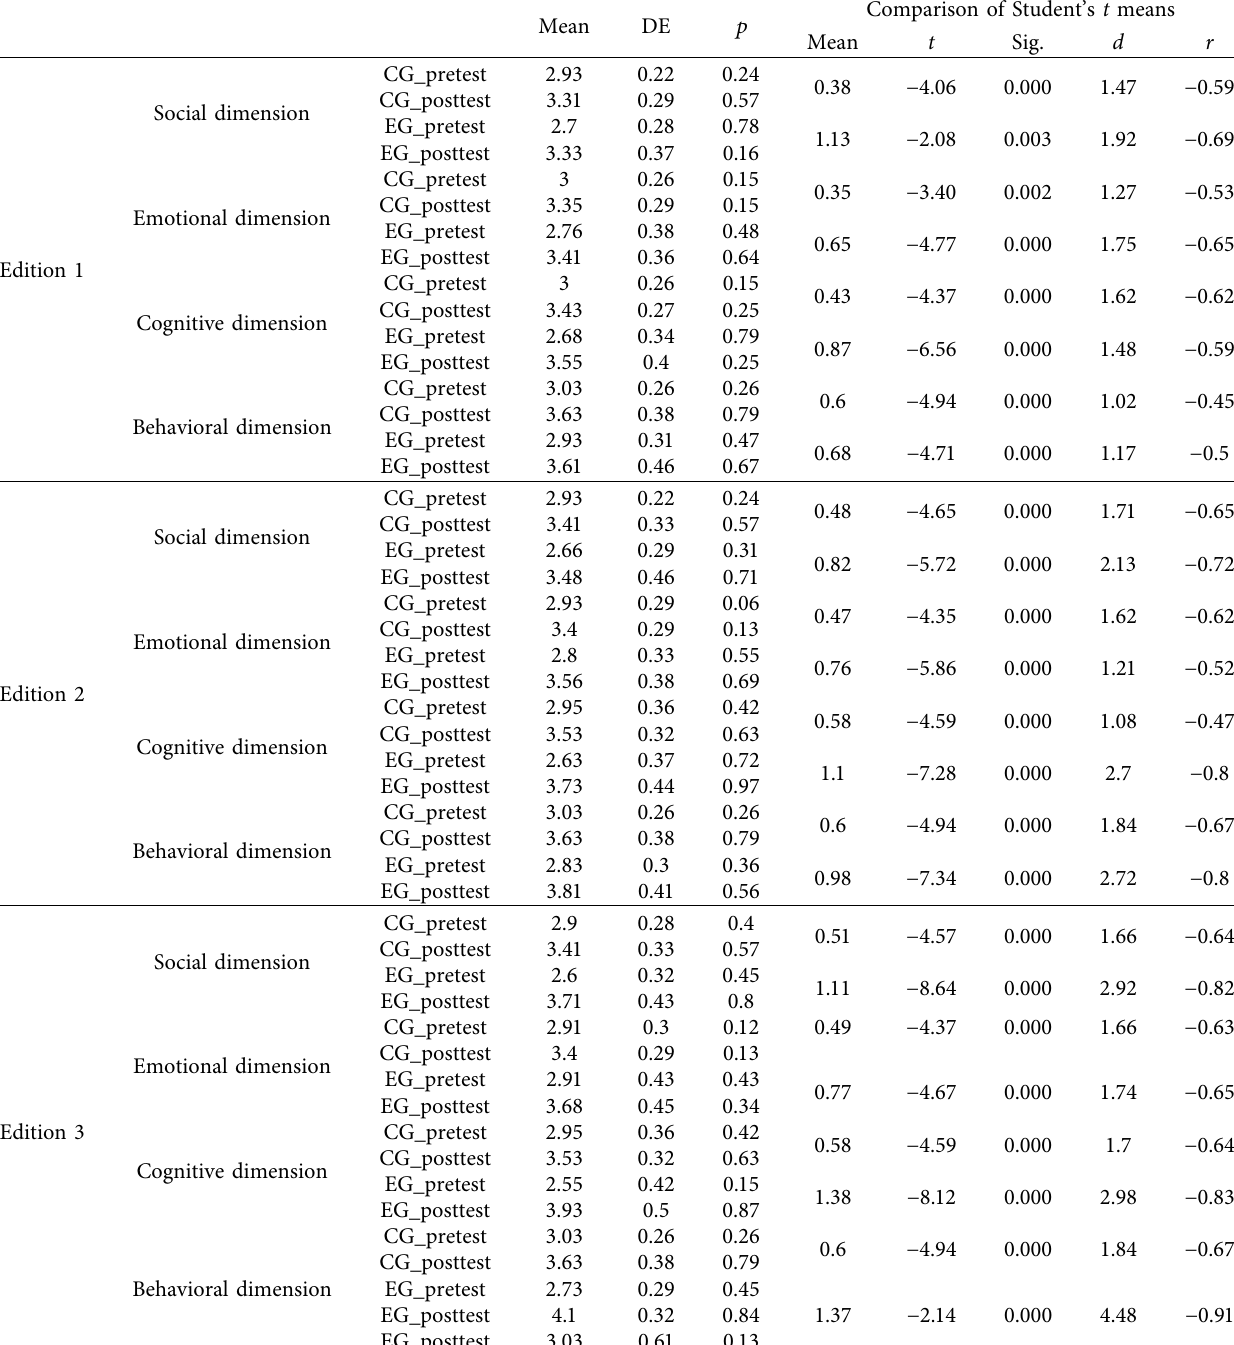
Table 2: Pre- and posttest statistics (first three